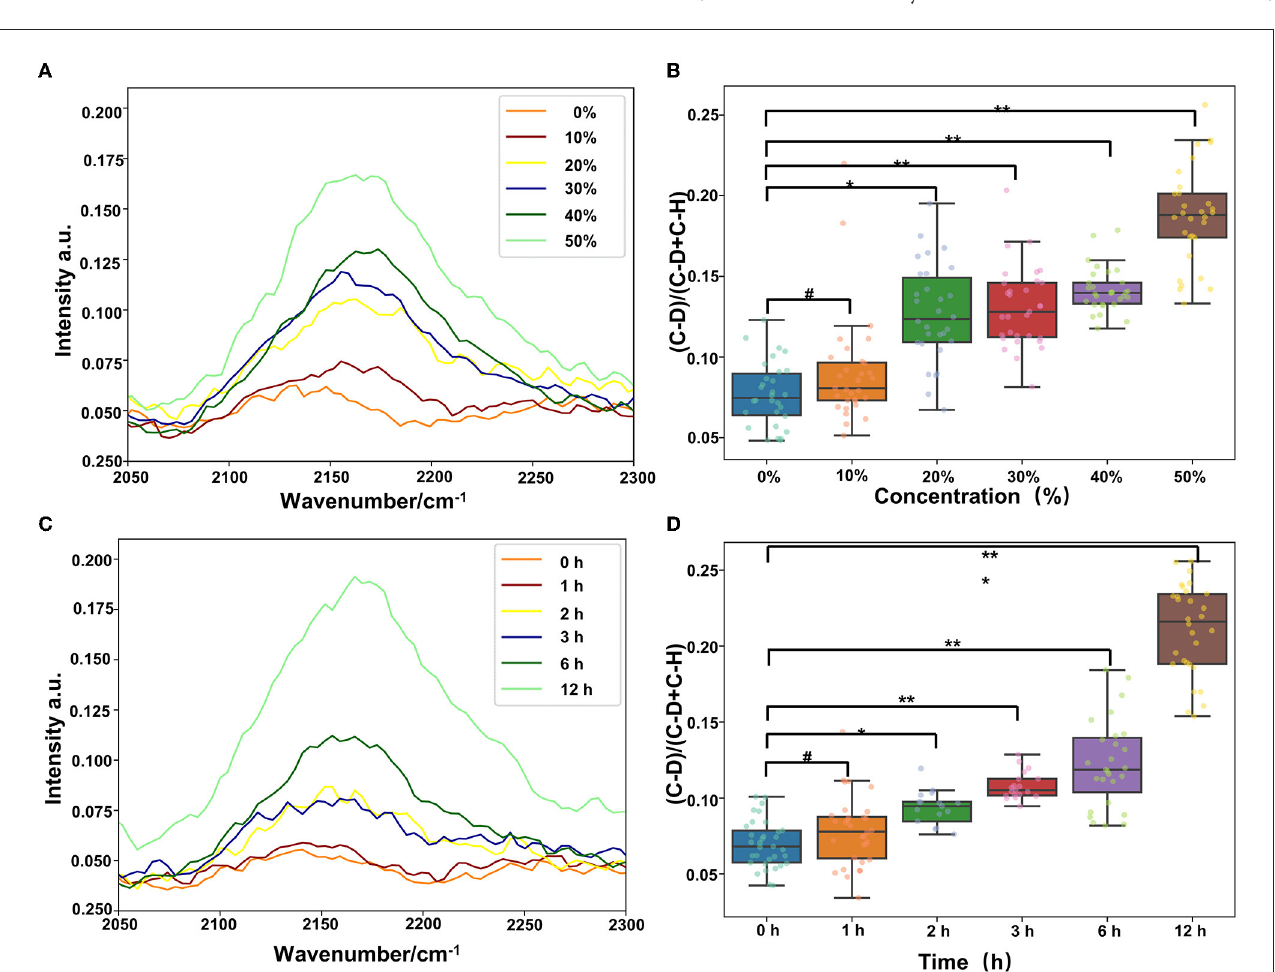
FIGURE6 Heavy water can quickly mark the activity of bacteria, and, combined with Raman spectroscopy, we can quickly detect the drug resistance ( # p > 0.05; * p < 0.05; ** p < 0.01; and *** p < 0.001). (A) C–D peak location map of Pseudomonas aeruginosa labeled with different heavy water concentrations. (B) Statistics of the relative peak intensity map of C–D labeled with different heavy water concentrations. (C) C–D peak location map of Pseudomonas aeruginosa labeled with different heavy water labeling time and (D) statistics of the relative peak intensity of C–D labeled with different heavy water labeling